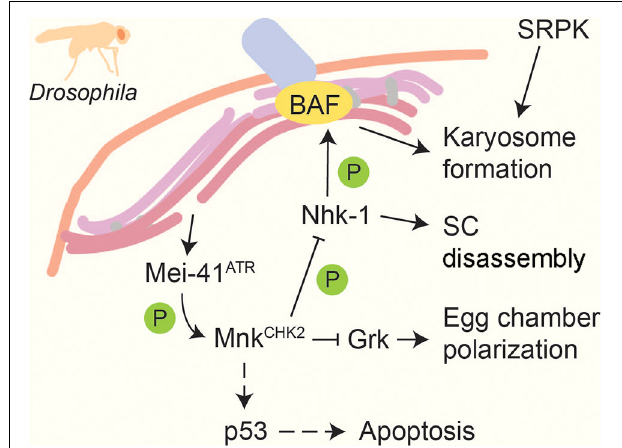
FIGURE 5 | Recombination and meiotic progression in Drosophila . DSBs activate the DNA-damage sensor kinase Mei-41 ATR , which in turn activates the effector kinase Mnk CHK 2 (Ghabrial and Schüpbach, 1999; Abdu et al., 2002). Mnk CHK 2 triggers p53-dependent apoptosis in response to persistent repair defects (Lu et al., 2010). Mnk CHK 2 also suppresses translation of Gurken (Grk), which promotes egg chamber polarization (Abdu et al., 2002). In addition, Mnk Chk 2 prevents meiotic progression by inhibiting Nhk-1, which normally prompts SC disassembly and induces karyosome formation by phosphorylating BAF (Ivanovska et al., 2005; Lancaster et al., 2007, 2010). Another kinase, SRPK, positively regulates karyosome formation in a Mnk CHK 2 - independent manner (Loh et al., 2012). Dashed lines indicate activation in response to persistent DNA damage